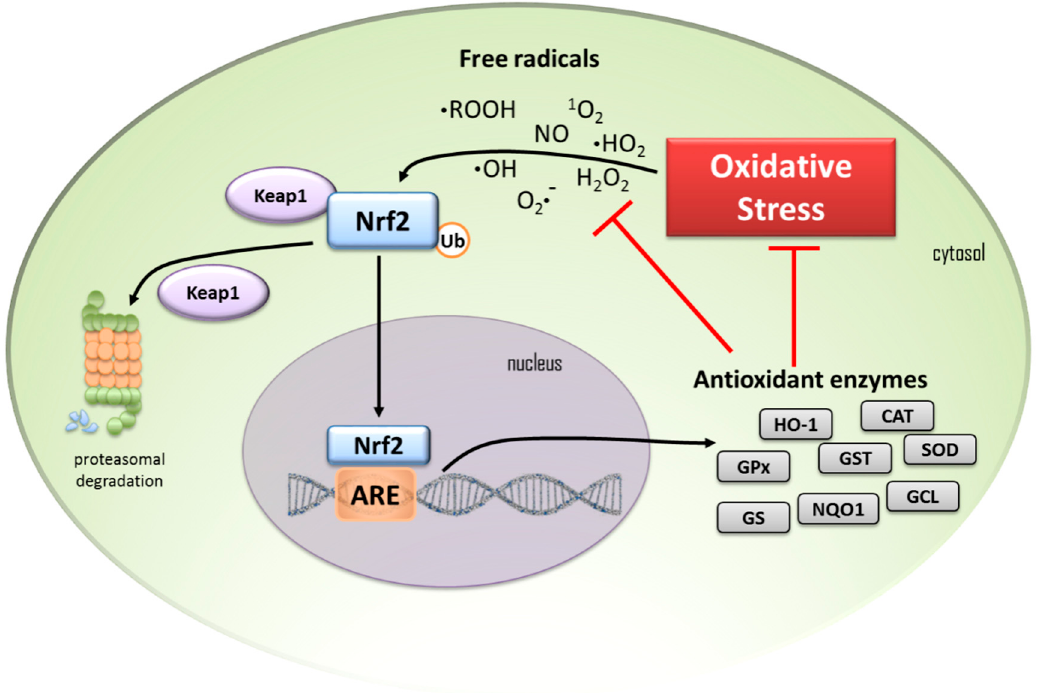
Figure 1. In cells under homeostatic conditions, cytosolic transcription factor Nrf2 is kept at low levels by proteasomal degradation trigged by the Keap1 protein complex. When cells are under oxidative stress, free radicals induce the Nrf2 to release from Keap1, escaping from proteasomal degradation, and it translocates to the nucleus. In the nucleus, Nfr2 binds to the ARE and starts the transcription of antioxidant enzymes as heme oxygenase-1 (HO-1), glutathione peroxidase (GPx), glutathione S-transferase (GST), superoxide dismutase (SOD), catalase (CAT), glutathione reductase (GR), NAD(P)H:quinone oxidoreductase 1 (NQO1), glutamine-cysteine ligase (GCL), and glutathione synthetase (GS). These enzymes act by reducing the cell oxidative stress and free radicals. Black arrows indicate pathways activation; Red T-bars indicate blocking processes.